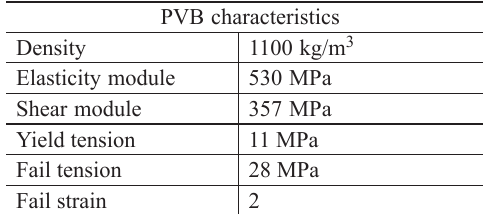
Table 3. PVB material